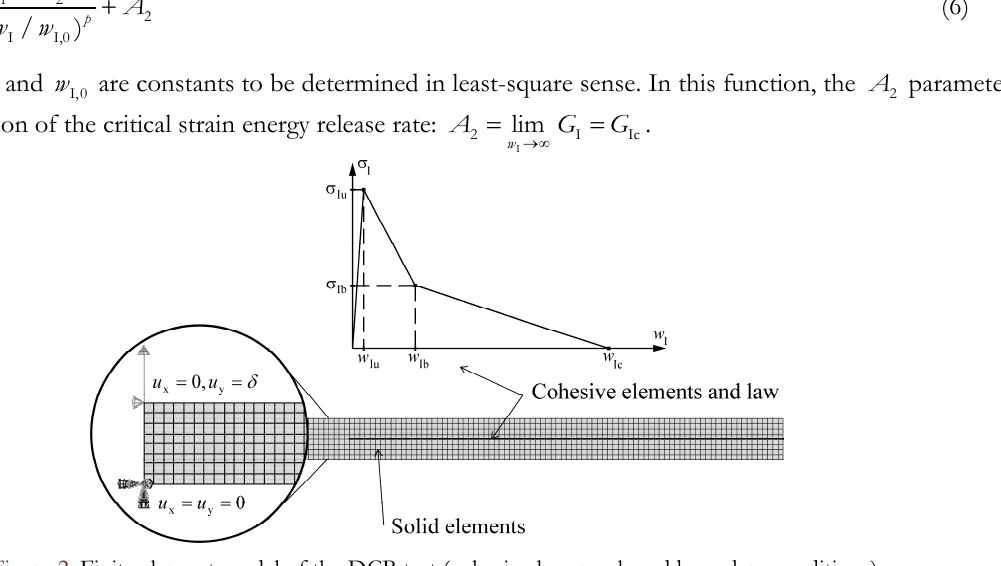
Figure 2: Finite element model of the DCB test (cohesive law, mesh and boundary